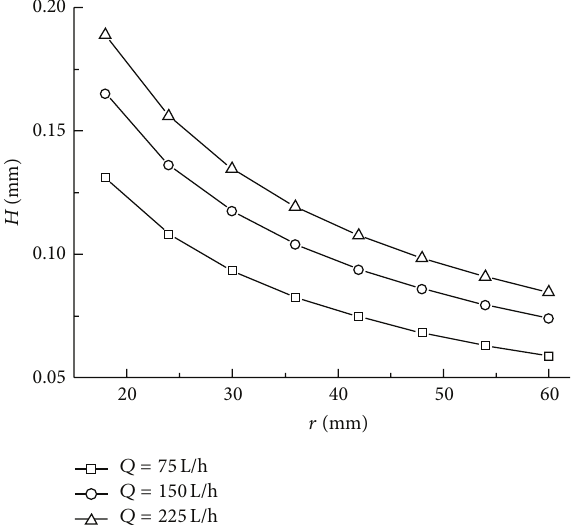
Figure 9: Influence of rotational speed on oil film thickness.